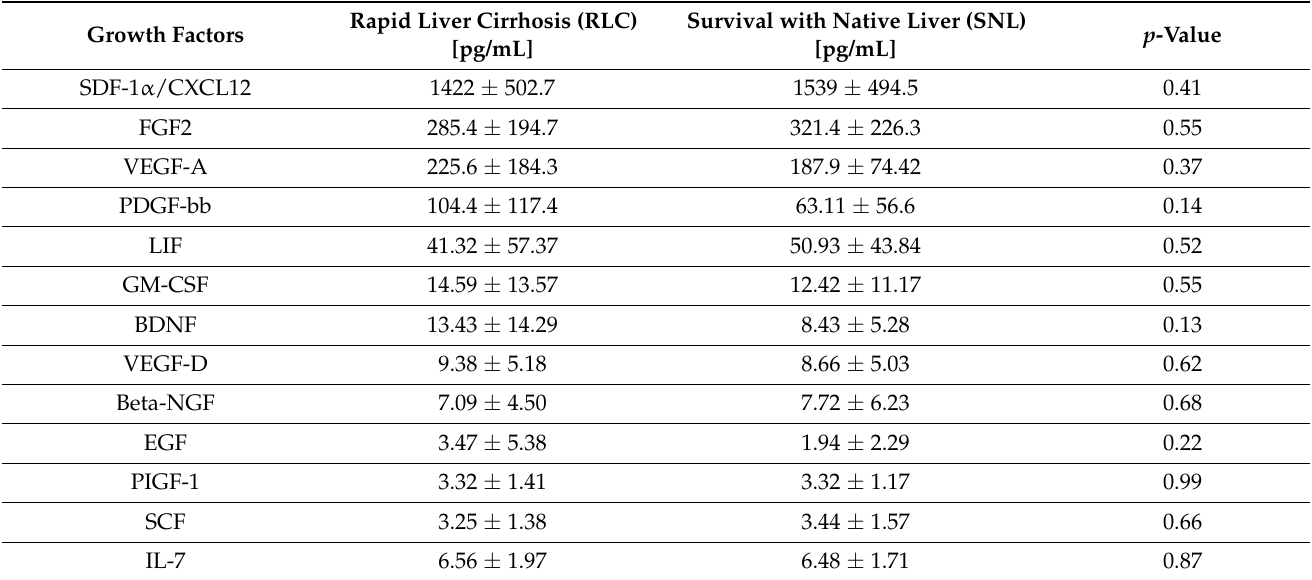
Table 2. Local growth factor